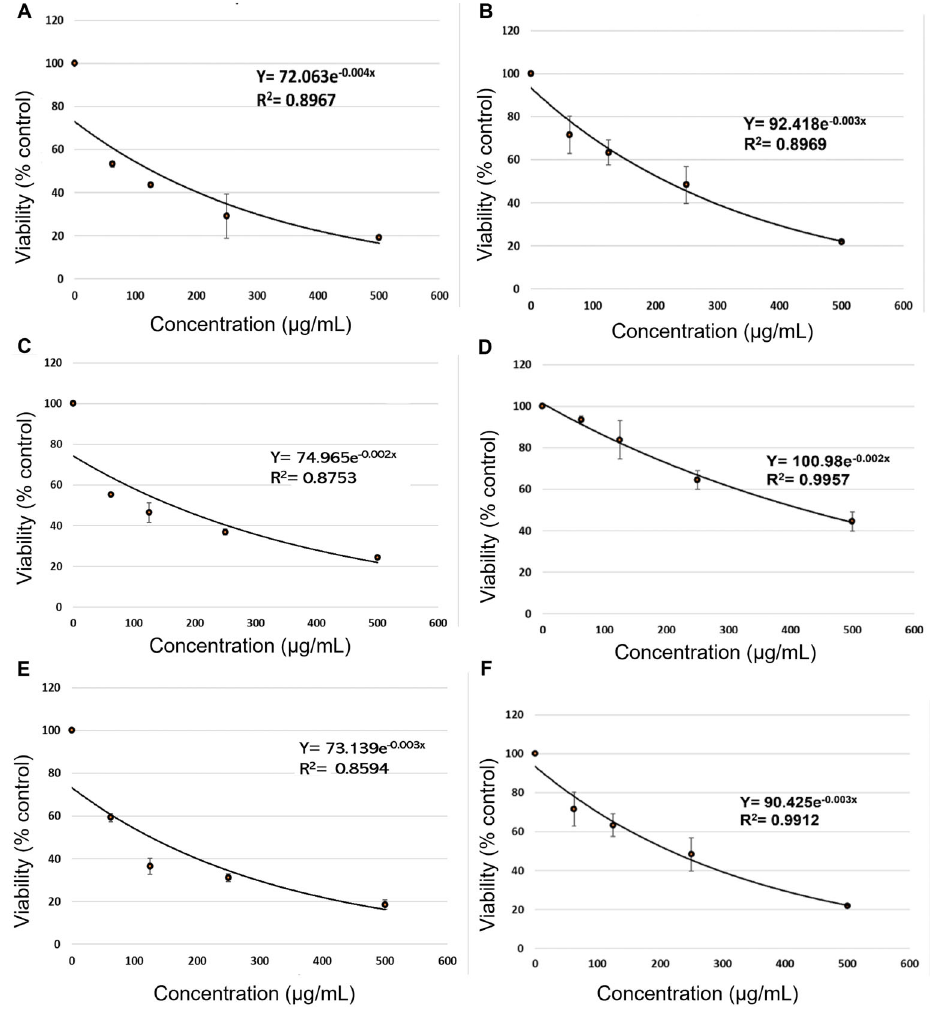
Figure 2. A , Cytotoxicity of terezine E against Hep-G2 cell line. B , Cytotoxicity of 14-hydroxyterezine D against Hep-G2 cell line. C , Cytotoxicity of terezine E against T47-D cell line. D , Cytotoxicity of 14-hydroxyterezine D against T47-D cell line. E , Cytotoxicity of terezine E against HCT-116 cell line. F , Cytotoxicity of 14-hydroxyterezine D against HCT-116 cell line. Results are reported as means ± SE of at least three independent experiments (3 replications each). Student ’ s t -test was used for statistical analyses. Table 2. Results of the docking